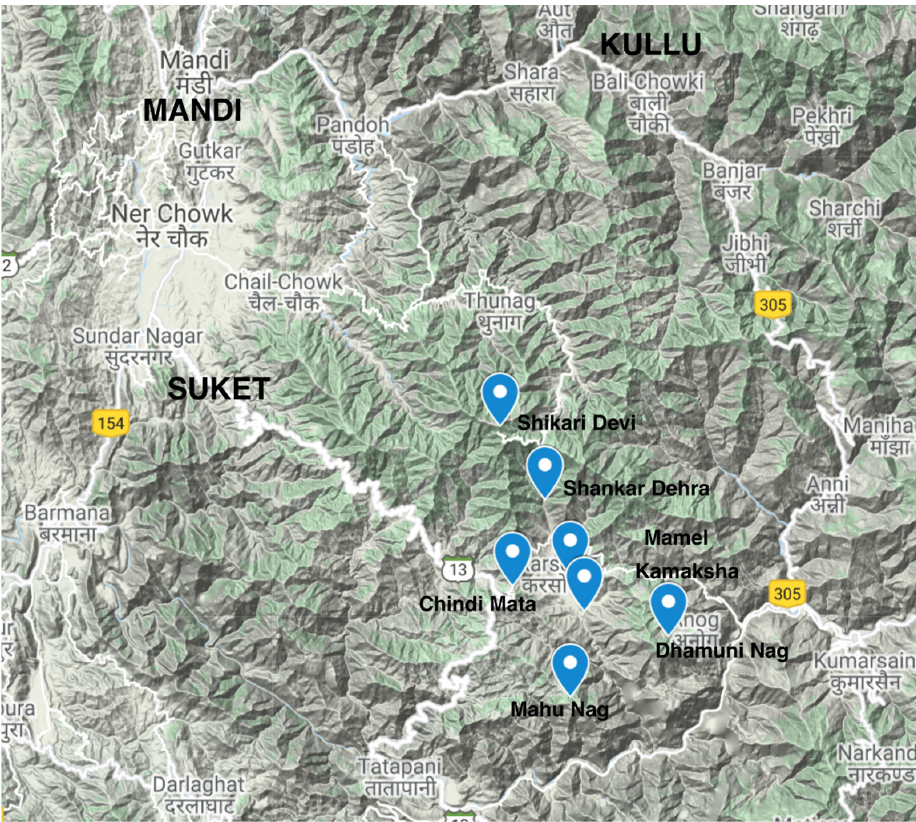
Figure 1. Karsog and neighboring regions. Adapted from Google Maps. Geographically, the valley of Karsog is locked between two ridges that diverge from the northerly summit of the “Hunter Goddess” (Shikari Devi) at its head and run all the way down to the mighty Sutlej River due south where they terminate. The only town of significance in the valley is the moderate settlement of Karsog. Situated at the center of the fertile valley, Karsog serves as the gateway for those arriving by road from other parts of the hills. The view of the valley is exceptionally serene. The absence of spectacular snowcapped mountains that feature in other parts of the hills is more than compensated for by the quilt-like canvas of lush greens (pre-harvest) and yellowish-brown paddies (post-harvest) that expands in a soft decline between the ridges in the shape of an uncan- nily neat, symmetrical triangle. 7 Interspersed with various huts and settlements, the view gives the (deceptive) impression of a sealed off, self-contained area that is cut off from the broader world that surrounds it (Figure 2).